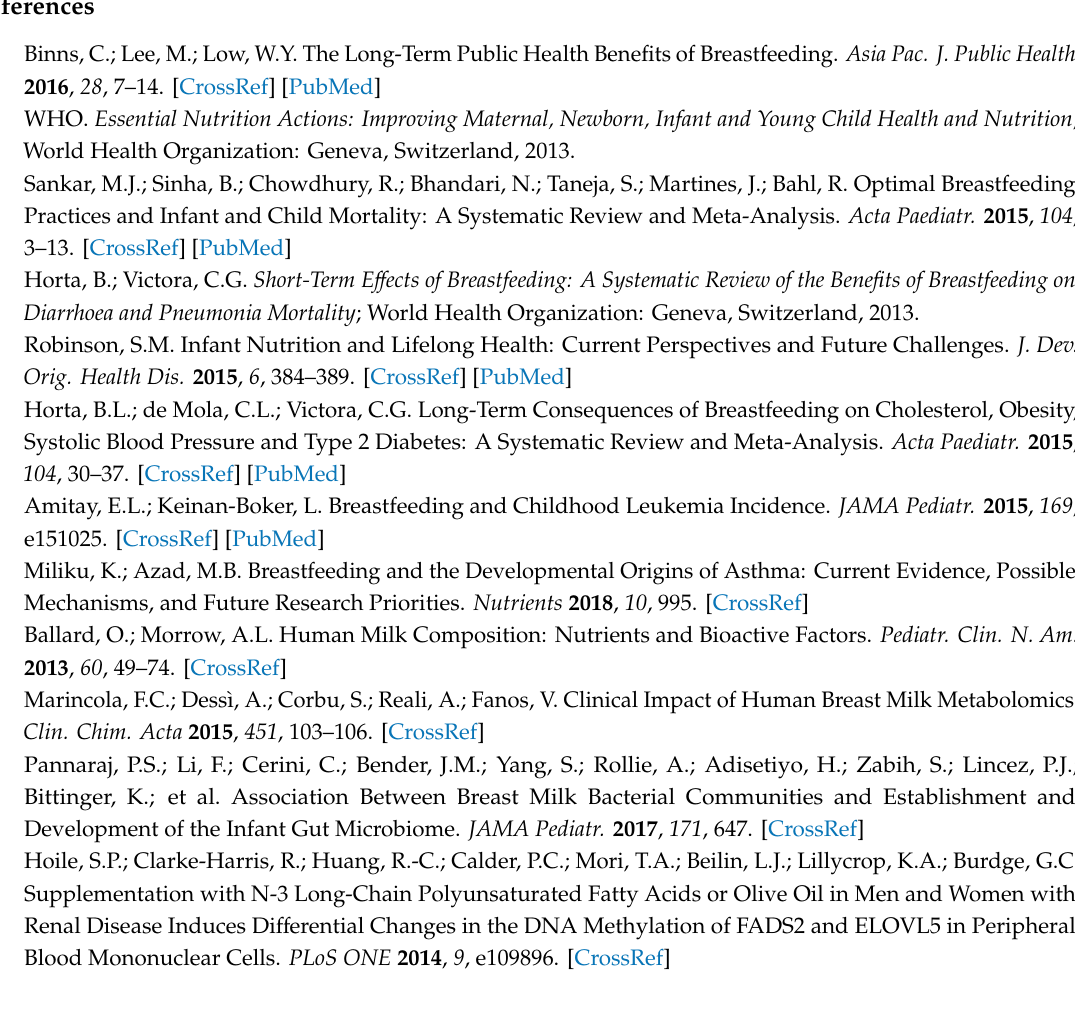
Table S1. Summary of the number of participants included in each analysis in this study; Table S2. Breastfeeding duration > 3 months vs. DNA methylation at 10 years (top 10 hits); Table S3. Cis-mQTL analysis results for cg03592955; Table S4. Cis-mQTL analysis results for cg08188863; Figure S1: Manhattan plot of the EWAS on breastfeeding duration > 3 months and DNAm in the IOWBC at 10 years; Figure S2: Quantile–Quantile (QQ) plot of the EWAS on breastfeeding duration > 3 months and DNAm in the IOWBC at 10 years; Figure S3. Manhattan plot for the DMR